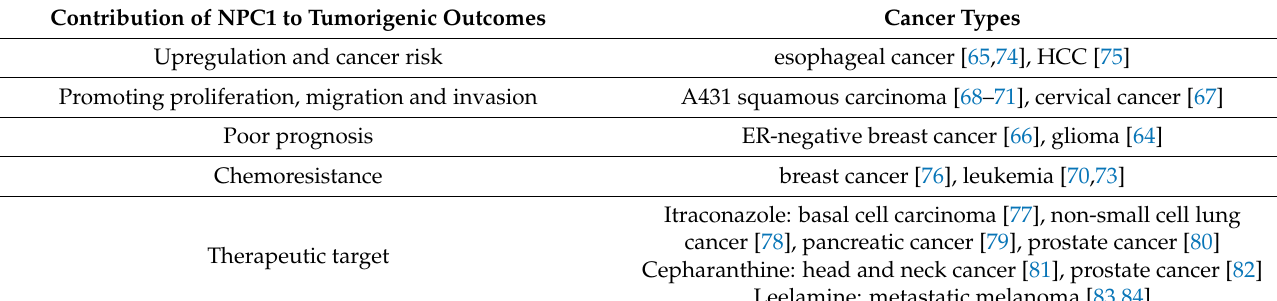
Table 2. Roles of NPC1 in